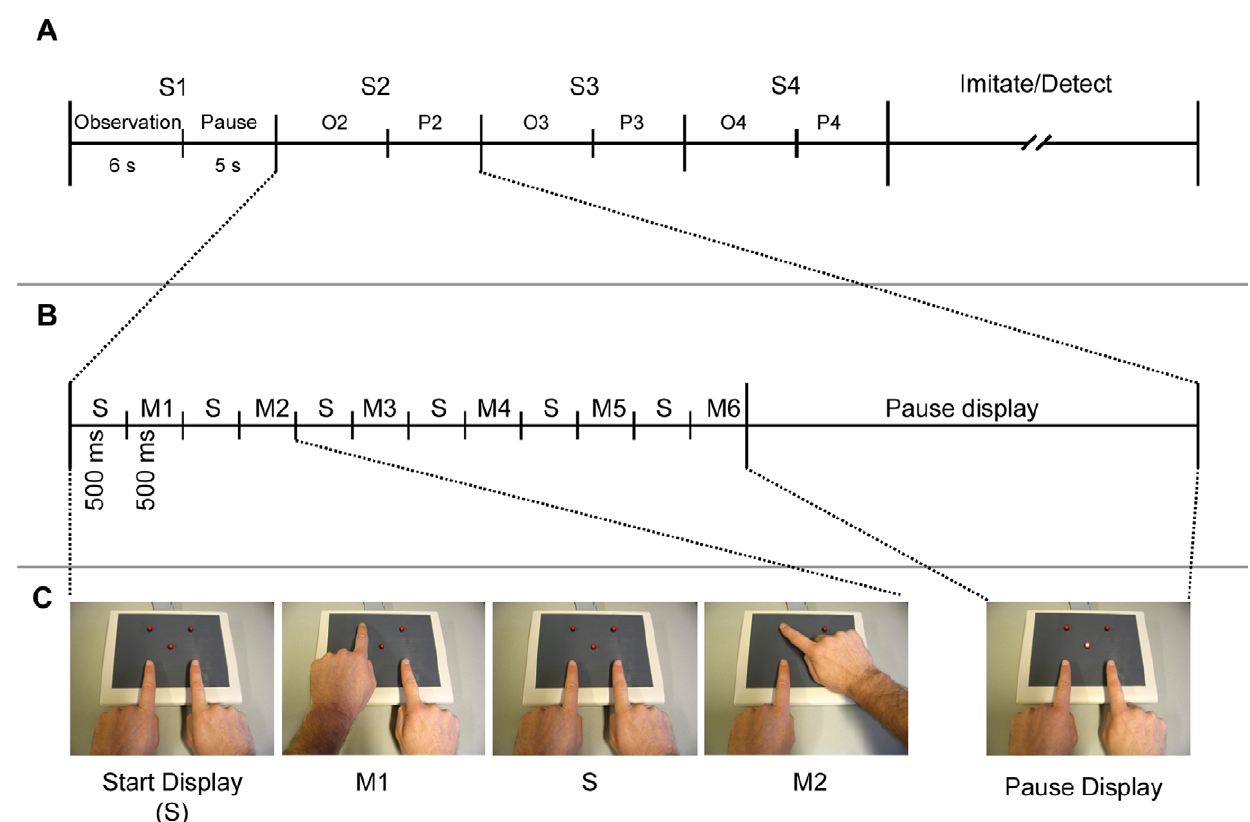
Figure 1. Schematic Overview of the Task Structure. (A) Each trial consisted of 4 repetitions (S1 – S4) of an observation interval (6 s) and subsequent pause interval (5 s). Following these 4 repetitions, subjects either tried to imitate the movement sequence from memory (imitation task) or responded if they had observed a catch movement in the action sequence (detection task). (B) Each observation epoch consisted of six button press movements, followed by a 5000 ms pause interval. Each button press movement consisted of a 500 ms display showing the left and right hand at the respective left and right start buttons (S) and a subsequent 500 ms apparent motion display (M) showing either the left or the right hand pressing an ipsi- or contralateral target button. (C) Examples of stimuli: Start display (S) showing the two hands pressing the start buttons; Example of an ipsilateral movement (M1); Example of a contralateral movement (M2); During the Pause display the central red button on the response box was illuminated.